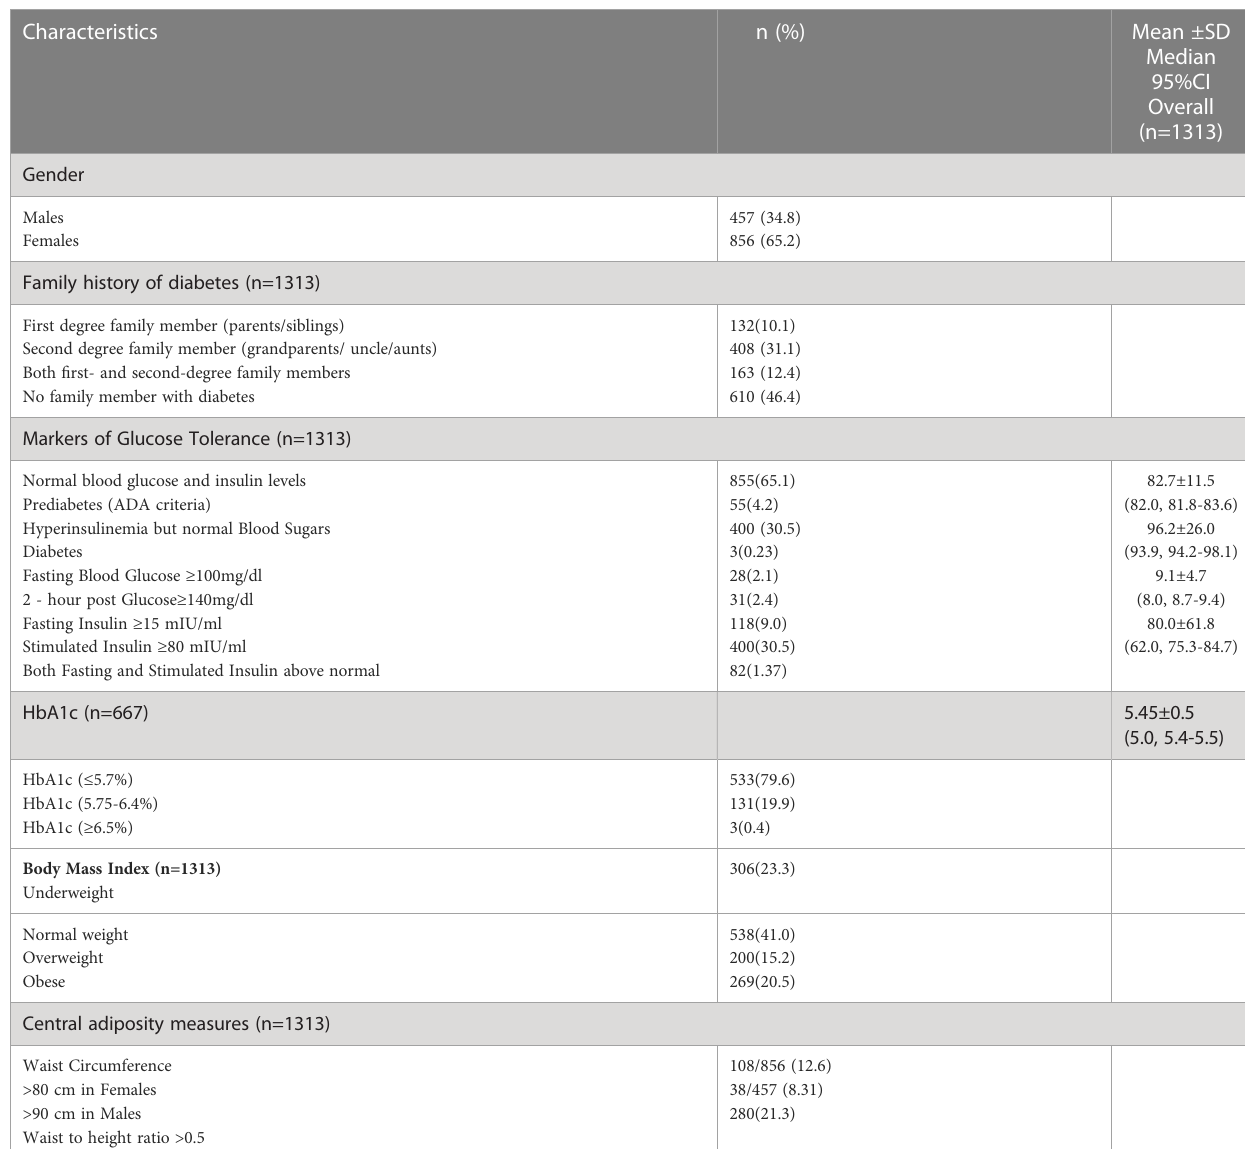
TABLE 1 Characteristics of 1313 study participants.